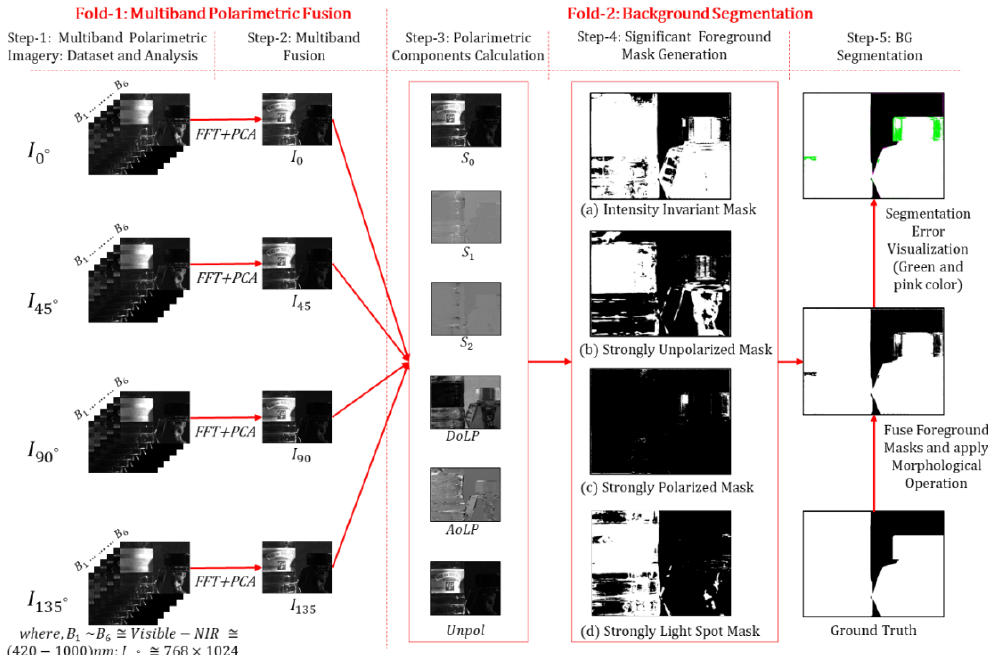
Figure 5. Proposed two-fold Background Segmentation (BS) framework.